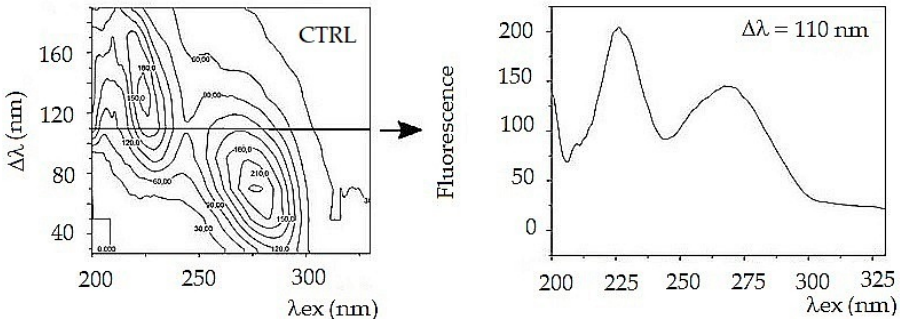
Figure 2. Constant wavelength synchronous map (CWM) tears of a healthy subject ( left ) with indication of a simple synchronous spectrum. It is shown on the right [12]. Authors have asked for permission to reprint Figure 5 from [12] and the request was